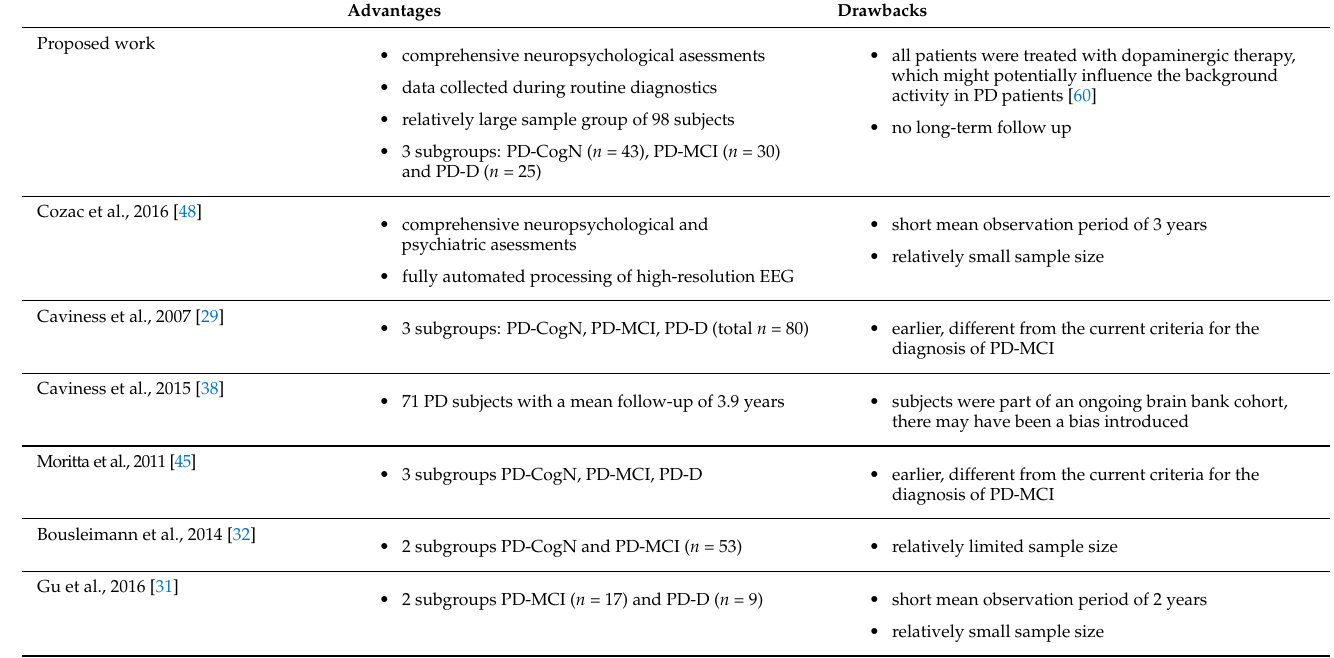
Table 4. The advantages and drawbacks of the proposed approach and other studies in the